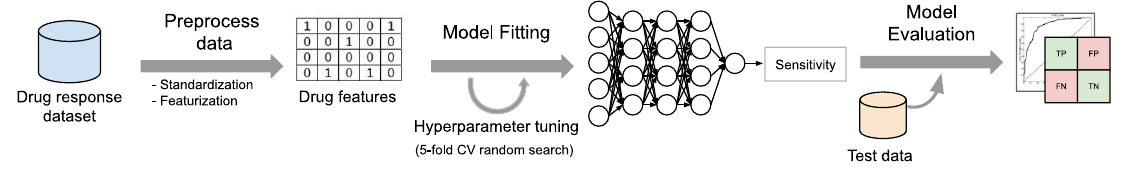
Figure 3: General data preprocessing and machine learning steps followed in this work.